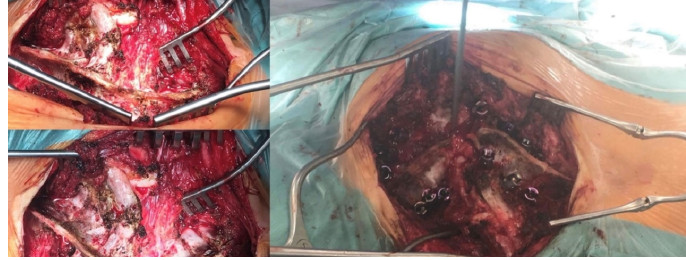
Figure 4. Posterior approach to the cervical and thoracic spine.